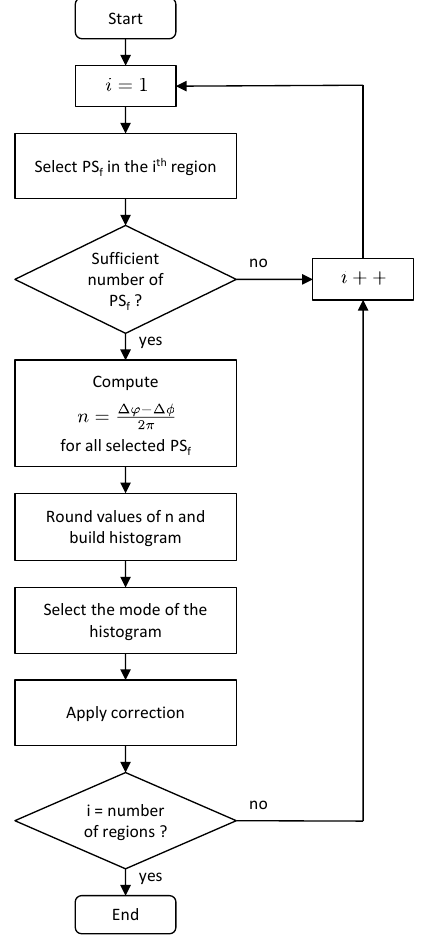
Figure 1. Flow chart of the Split-Band Interferometry-assisted phase unwrapping